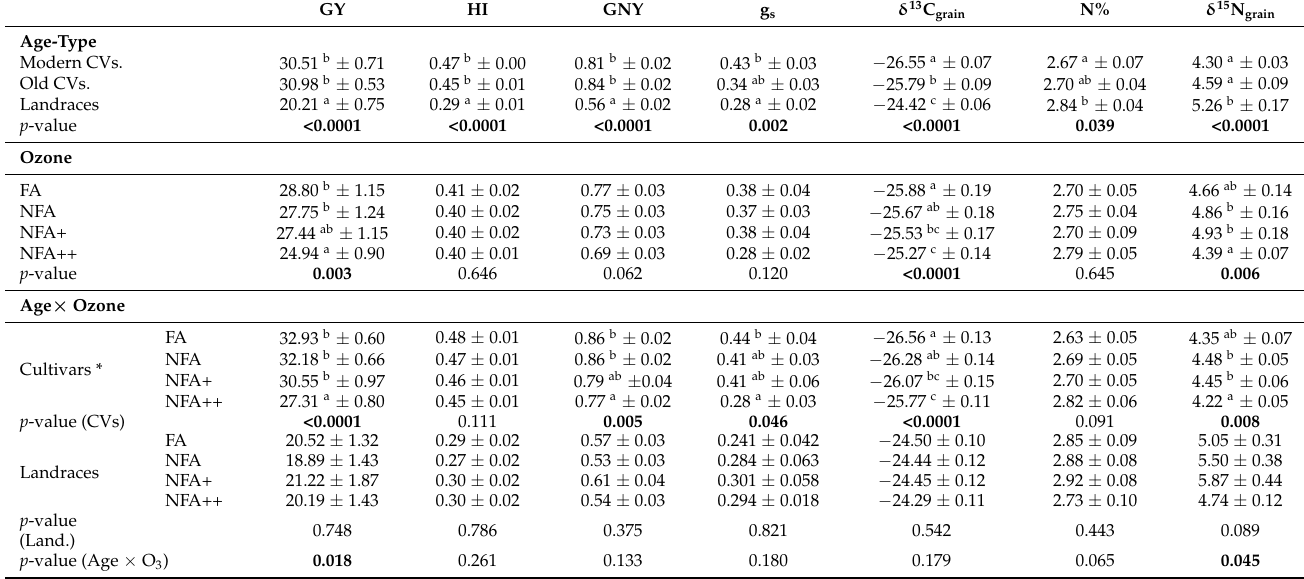
Table 3. Ozone and age type effects on yield parameters, g s and isotopic signals: GY, grain yield (g pot − 1 ); HI, Harvest Index; GNY, grain nitrogen yield (g pot − 1 ); g s , stomatal conductance (mmol H 2 O s − 1 ); δ 13 C, stable carbon isotope composition (‰) of grains; N, nitrogen concentration (% DW); δ 15 N, stable nitrogen isotope composition (‰) of grains. FA = charcoal filtered air, NFA = non filtered air, NFA+ = non filtered air supplemented with 20 nl L − 1 of O 3 , NFA++ = non filtered air supplemented with 40 nL L − 1 of O 3 ; Mean values ± SE. Different letters indicate statistically significant differences in the mean ( p < 0.05). GY HI GNY g s δ 13 C grain N% δ 15 N grain Age-Type Modern CVs.